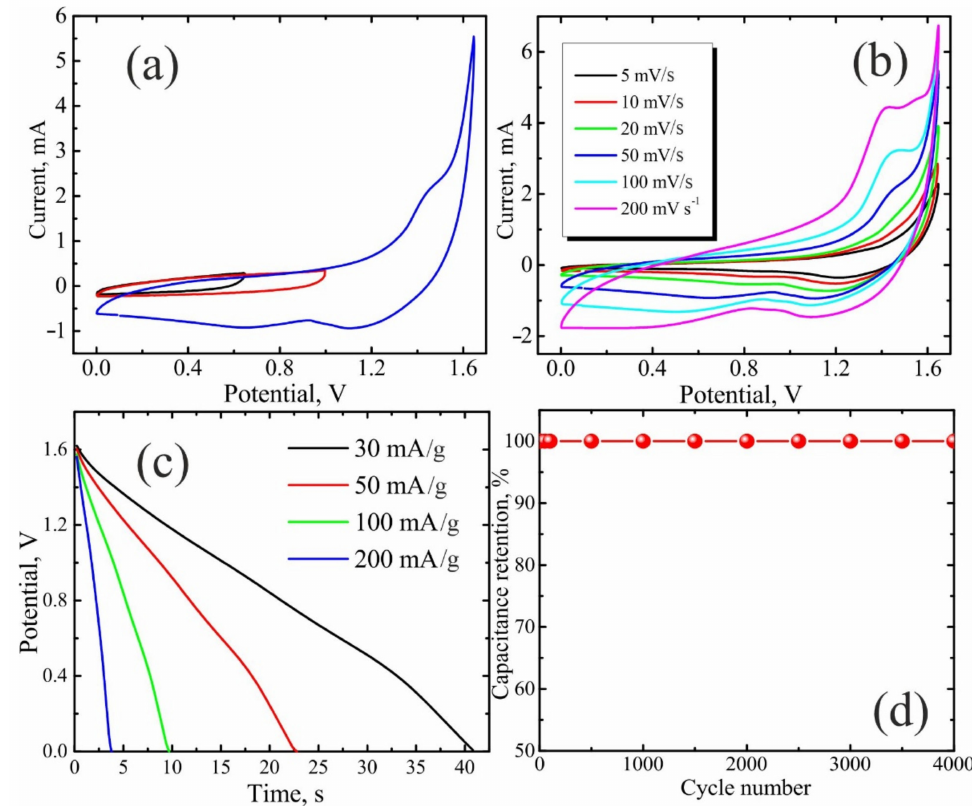
Figure 9. Electrochemical performance of the asymmetrical two-electrode cell with carbon black Timcal Super C65 and NiO/C (60 wt% NiO) as negative and positive electrodes, respectively, in a 6 M KOH solution: ( a ) cyclic voltammogram (CV) curves within different potential ranges up to 0.65, 1 and 1.65 V at 50 mV s − 1 ; ( b ) CV curves at various scan rates; ( c ) galvanostatic discharge curves at various current densities; ( d ) cycling stability at a current density of 0.1 A g − 1 during 4000 cycles. The voltage supplied by a single asymmetrical two-electrode cell with a NiO/C positive electrode (60 wt% NiO) and an aqueous electrolyte is sufficient for the use in different micro-devices, for example, in powering quartz clocks with a power rating of 1.5 V for about 30 min (Figure 10).